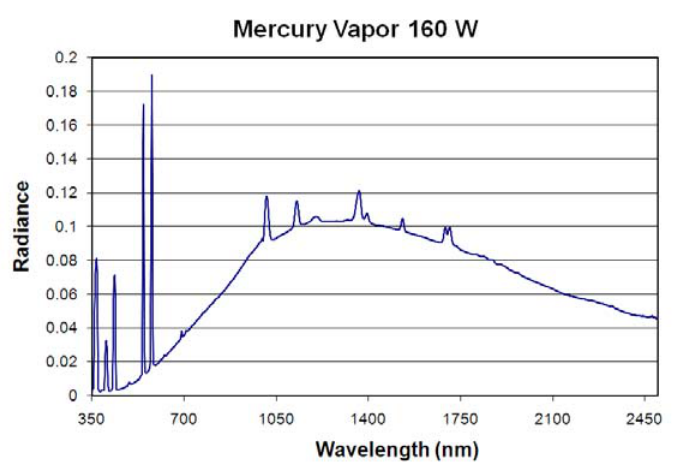
Figure 11. Emission spectrum of a mercury vapor lamp.